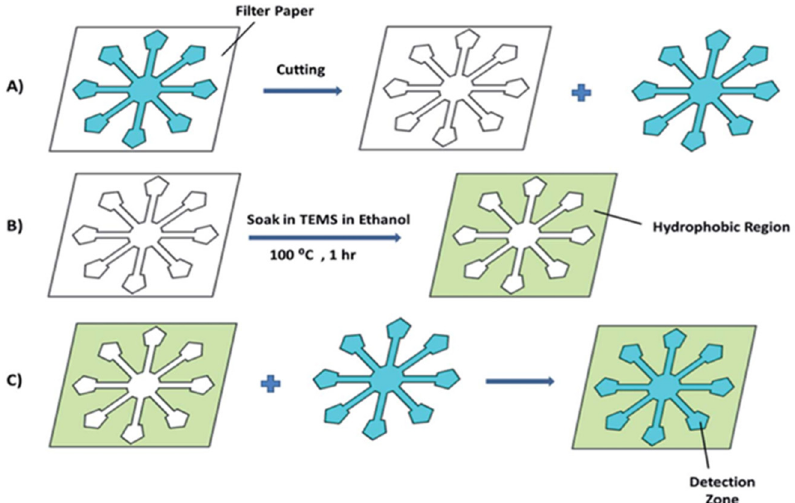
Figure 10. Surface modification of filter paper. ( A ) pattern design and cutting of the filter paper device, ( B ) Salinization of the hydrophilic filter paper device; ( C ) hydrophilic–hydrophobic contrast generated on the filter paper. Reprinted with permission from [139] under an Open-Access Creative Common CC license to RSC.